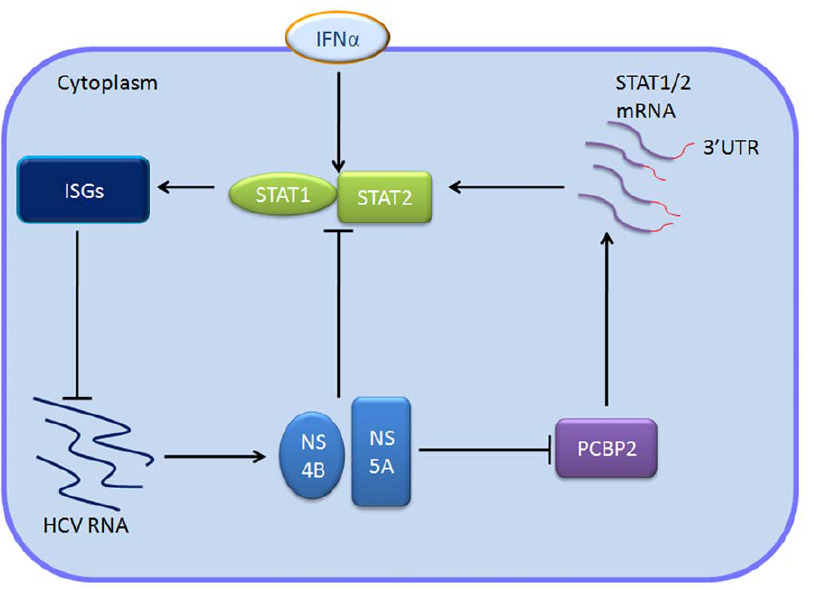
Figure 7. Model of PCBP2-modulating effect of IFN- a against HCV. PCBP2 enhances the antiviral activity of IFN- a through stabilizing the mRNA of STAT1 and STAT2. This accordingly, increases the protein level of the two molecules. The protein level increase also enhances the effect of IFN- a against HCV.